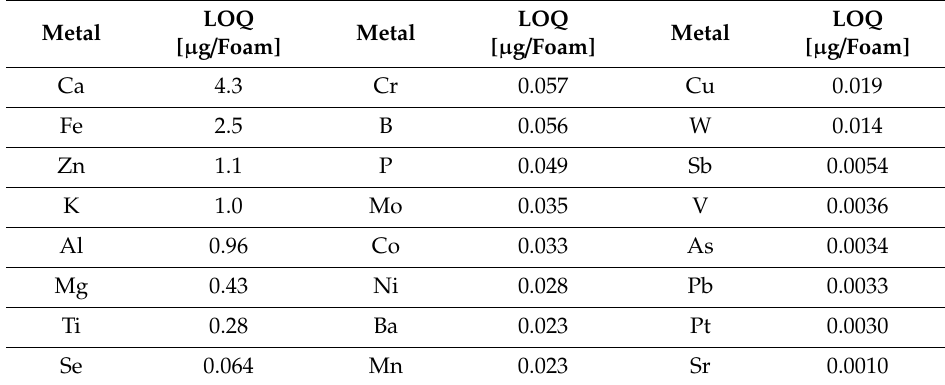
Table 5. Limits of Quantitation (blank corrected) of elements in DIS sampler foam (mean of ten foam pieces, data from Wisconsin State Hygiene Laboratory, Madison, WI,